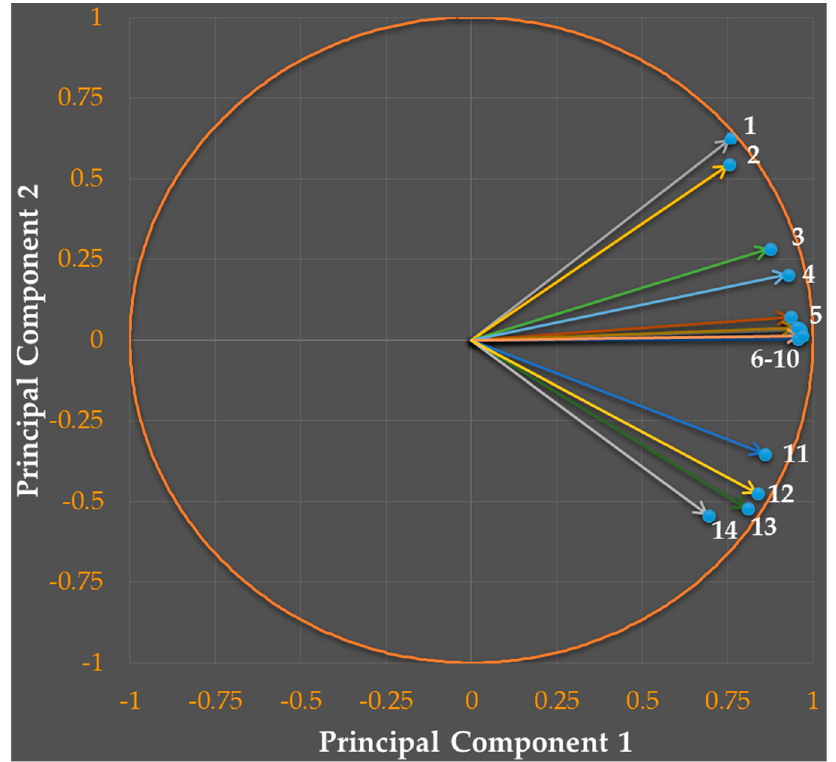
Figure 6. Two-dimensional mapping of the loadings of variables (variously colored vectors) indicating their (i) positions towards a circle of correlation; and (ii) relationships to both Principal Component 1 and 2. Numbering of the vectors was as follows: 1 (the vector built on the log (1/ MIC [M]) values, which were observed after 14-d in vitro cultivation against MT v H 37 R v ), 2 ( MT v H 37 R v , 21-d), 3 ( MK 235/80, 7-d), 4 ( MA 330/80, 14-d), 5 ( MK 235/80, 21-d), 6 ( MK 235/80, 14-d), 7 ( MK 6509/96, 14-d), 8 ( MK 6509/96, 7-d), 9 ( MA 330/80, 21-d), 10 ( MK 6509/96, 21-d), 11 ( MT a H 37 R a , 7-d), 12 ( MM , 21-d), 13 ( MK DSM, 7-d) and 14 ( MS , 3-d), respectively.